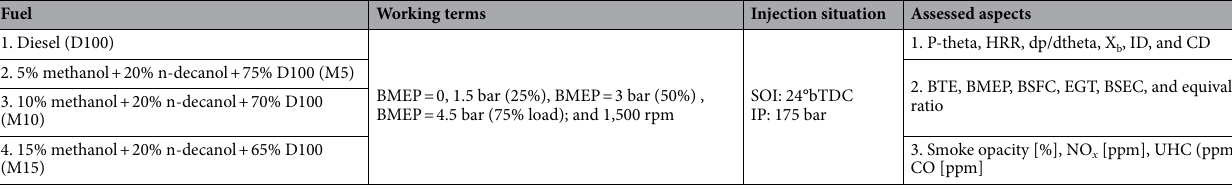
Table 2. Test environments.